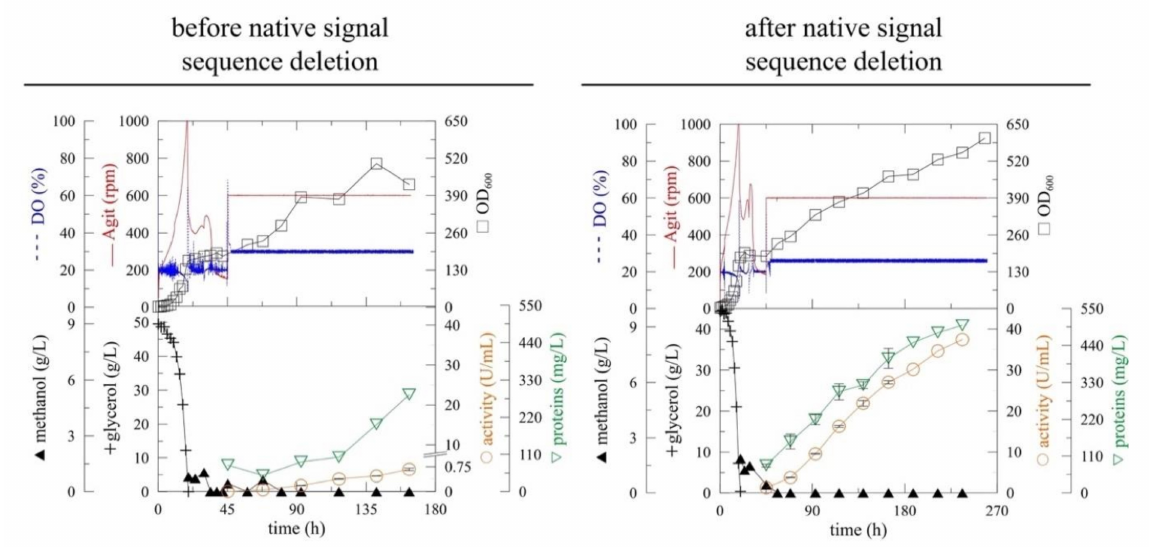
Figure 1. The improvement of ( α -MF)-driven secretion of myrosinase in Pichia pastoris before ( myr ) [13] and after ( myr - ∆ 19) the deletion of the native N-terminal signal sequence. The expression was performed in Pichia pastoris KM71H in a 3-L laboratory fermenter at 20 ◦ C, pH 6 [DO (Dissolved oxygen), Agit (agitation), OD 600 (optical density measured at 600